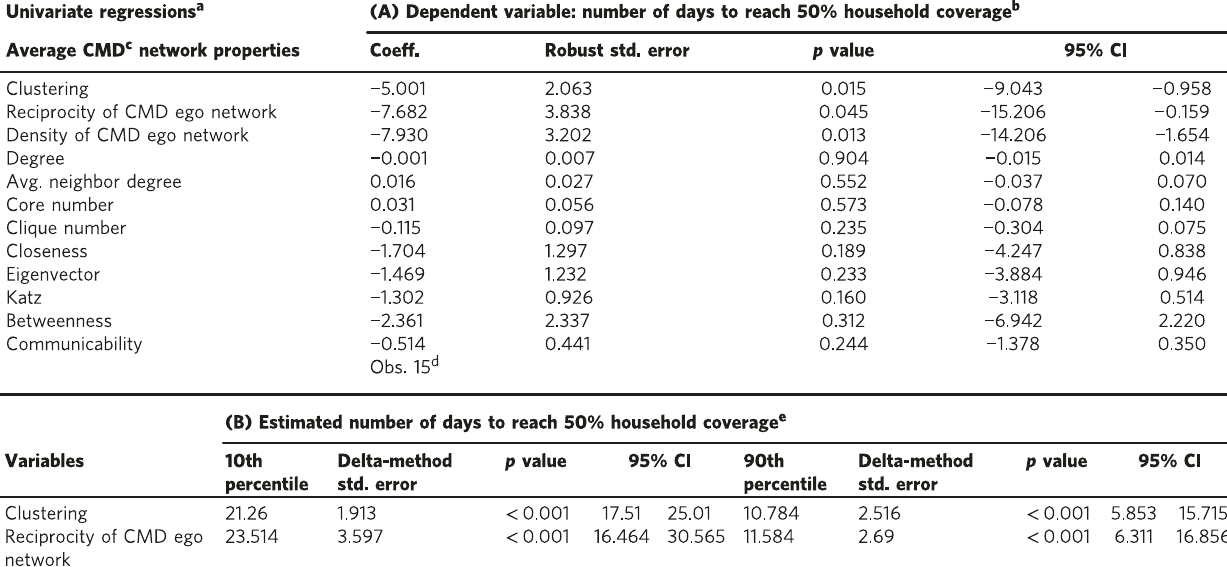
Table 2 In fl uence of CMD network properties on speed of treatment diffusion